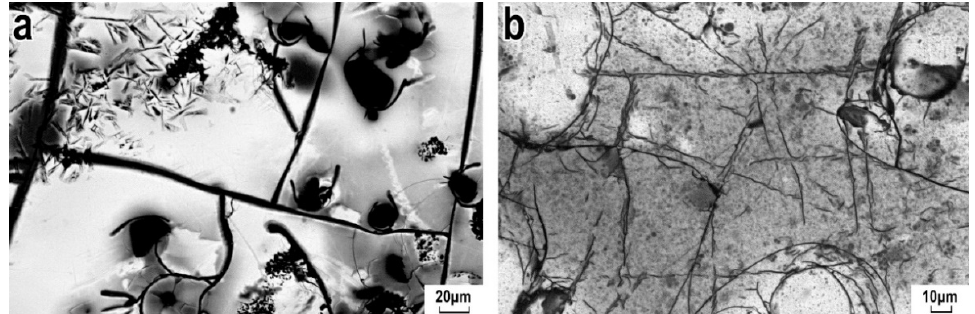
Figure 10. SEM images of surface texture of the black area ( a ) and red area ( b ) on the separate fragment of the figurine. The magnification is 346×, 368×.